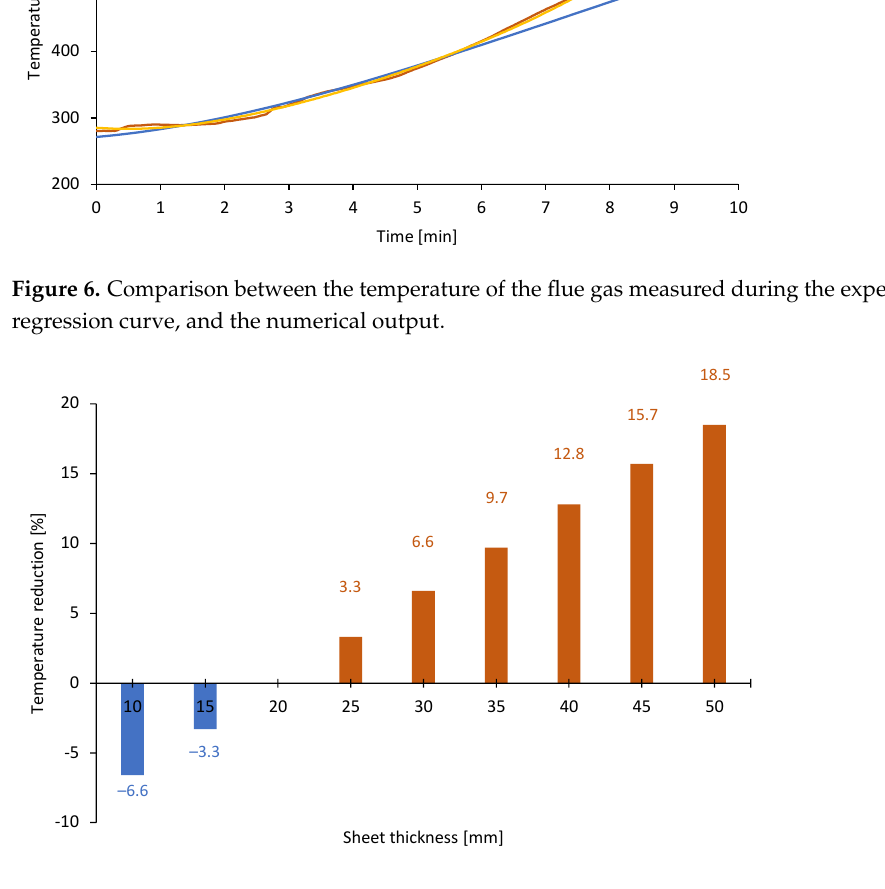
Figure 7. The reduction of temperature on the second side of the metal sheet with the increase in its thickness.